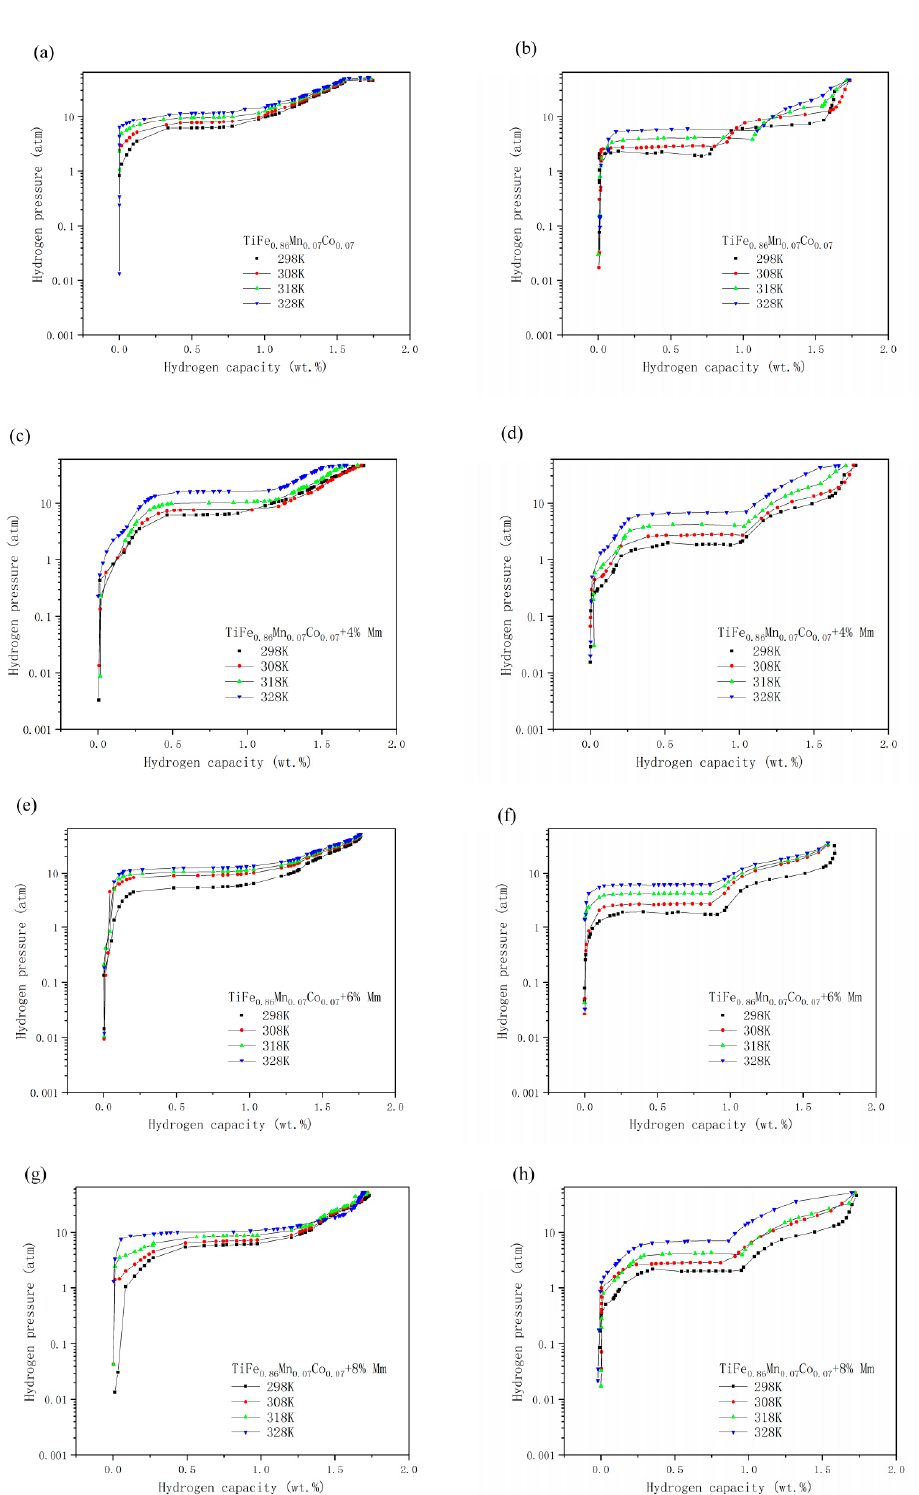
Figure 3. Absorption and desorption pressure-composition (P–C) isotherms of TiFe 0.86 Mn 0.07 Co 0.07 + x% Mm (x = 0,4,6,8) alloys. ( a , c , e , g ) Absorption; ( b , d , f , h ) Desorption.